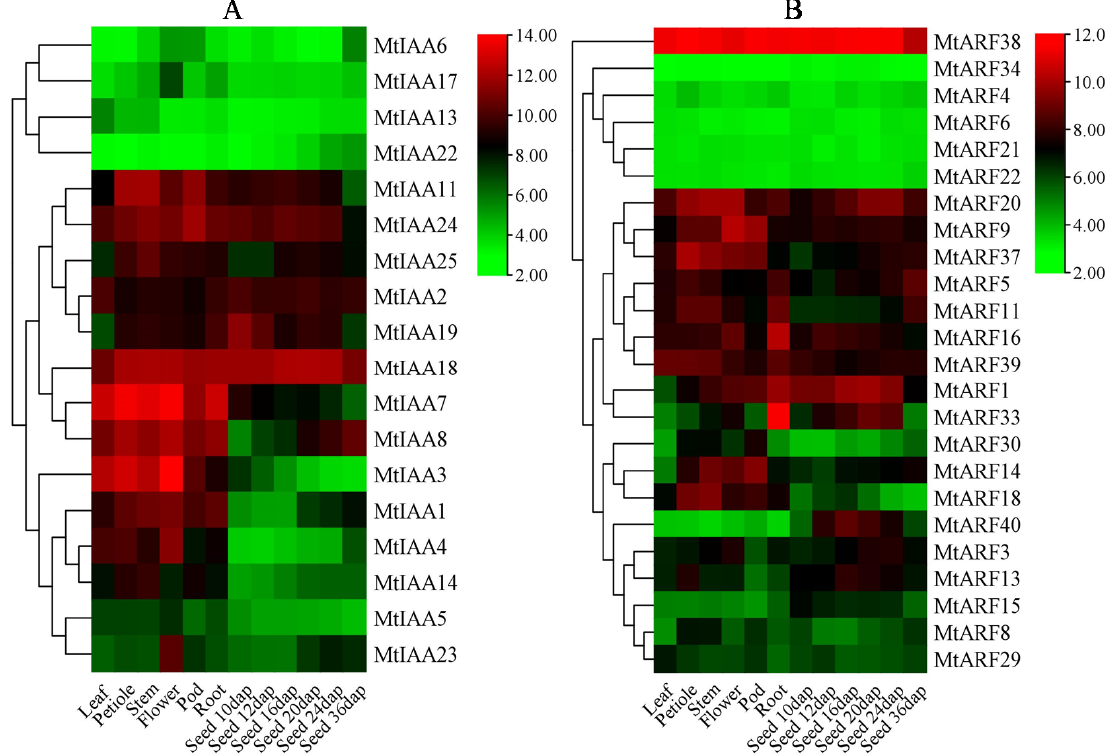
Figure 4. Spatial and temporal expression of MtIAA and MtARF genes. ( A ) MtIAA ; ( B ) MtARF . MtIAA and MtARF expression levels are shown as the log2-based fluorescence intensity values from MtGEA (https://mtgea.Noble.orgv3/ (accessed on 24 January 2021)). DAP indicates days after pollination.